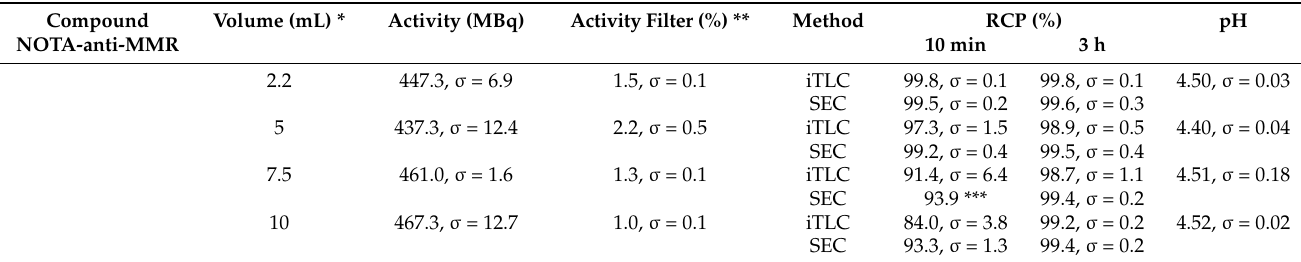
Table 5. Exploratory study of combining 20%EtOH with 5 mg/mL AA in increasing radiolabeling volumes.